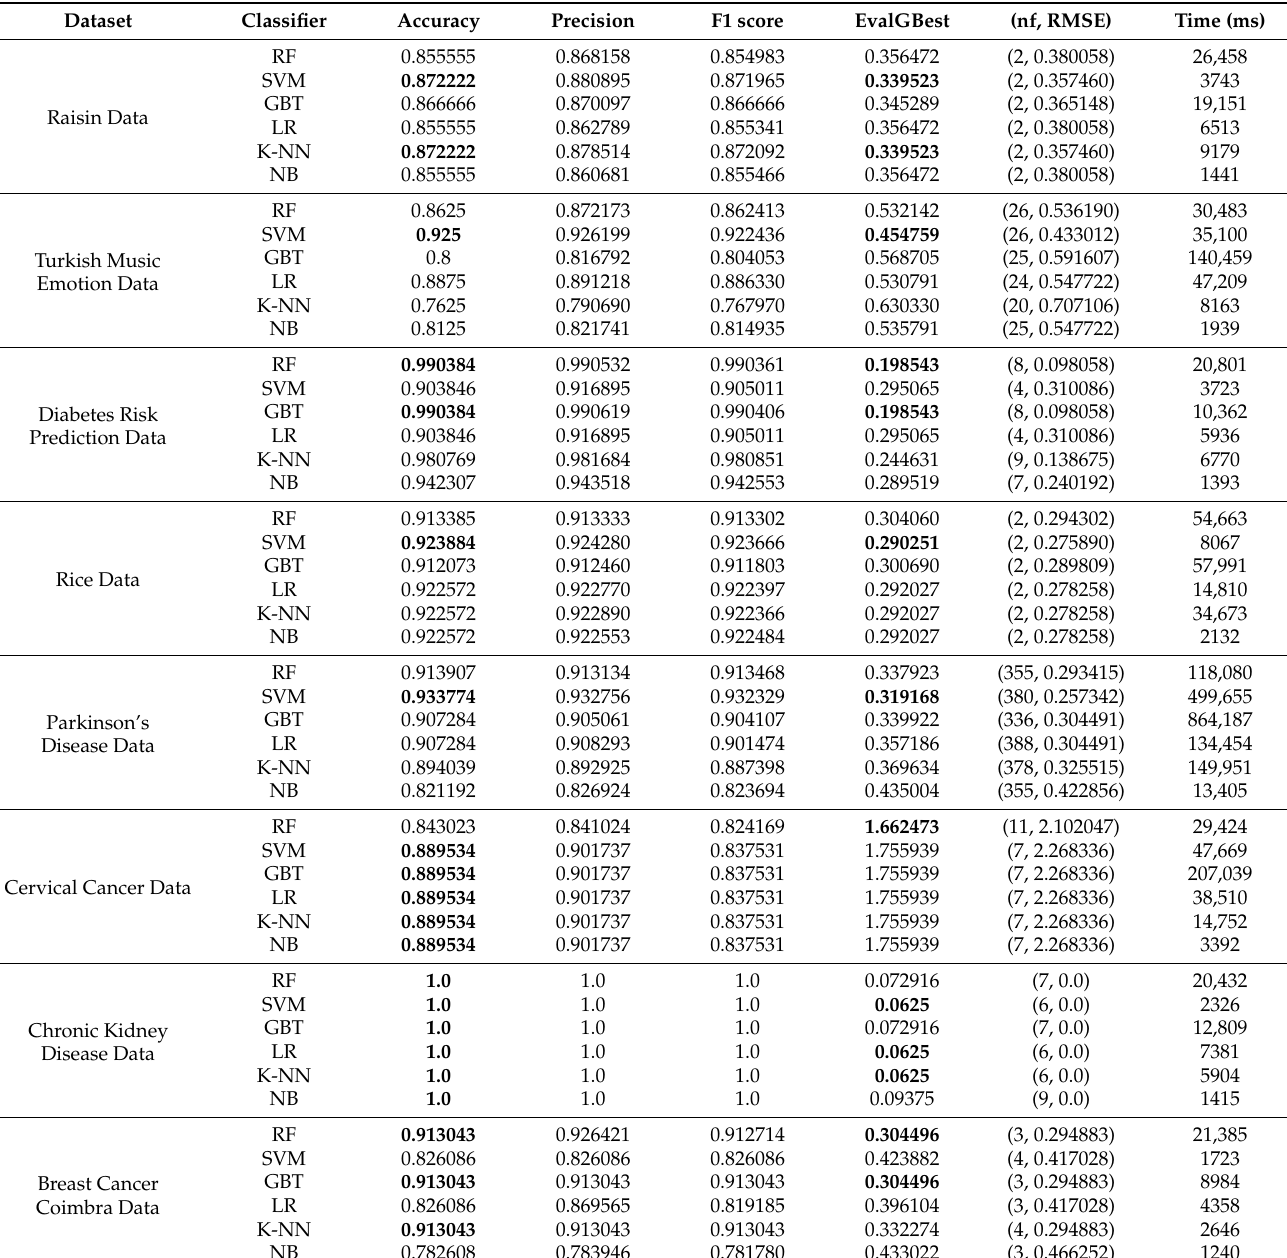
Table 11. BCSA Experimental Results